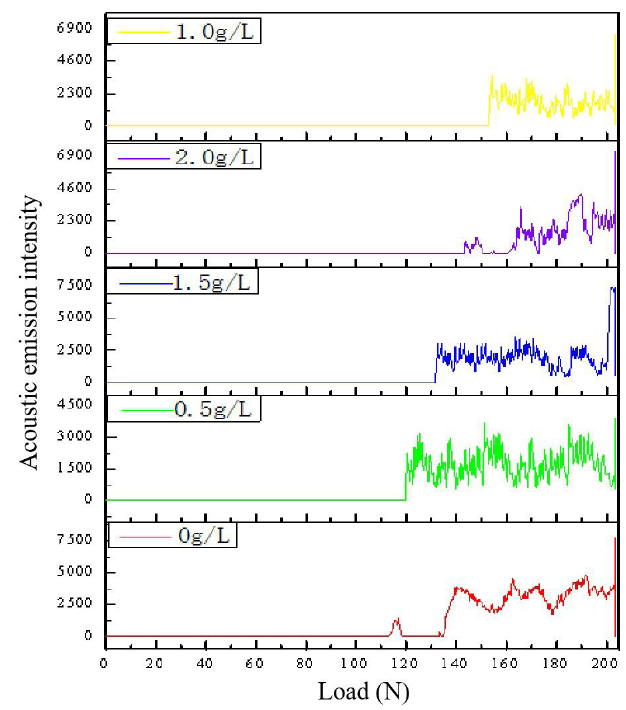
Figure 12. Acoustic emission spectra of Ni-Co matrix composite coatings.